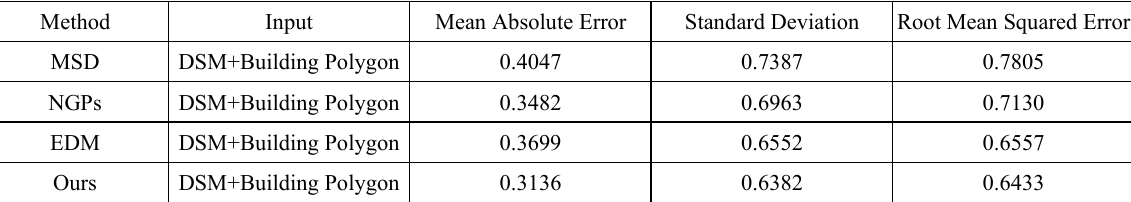
Table 2. The test results (in meter) of four different building height estimation methods.